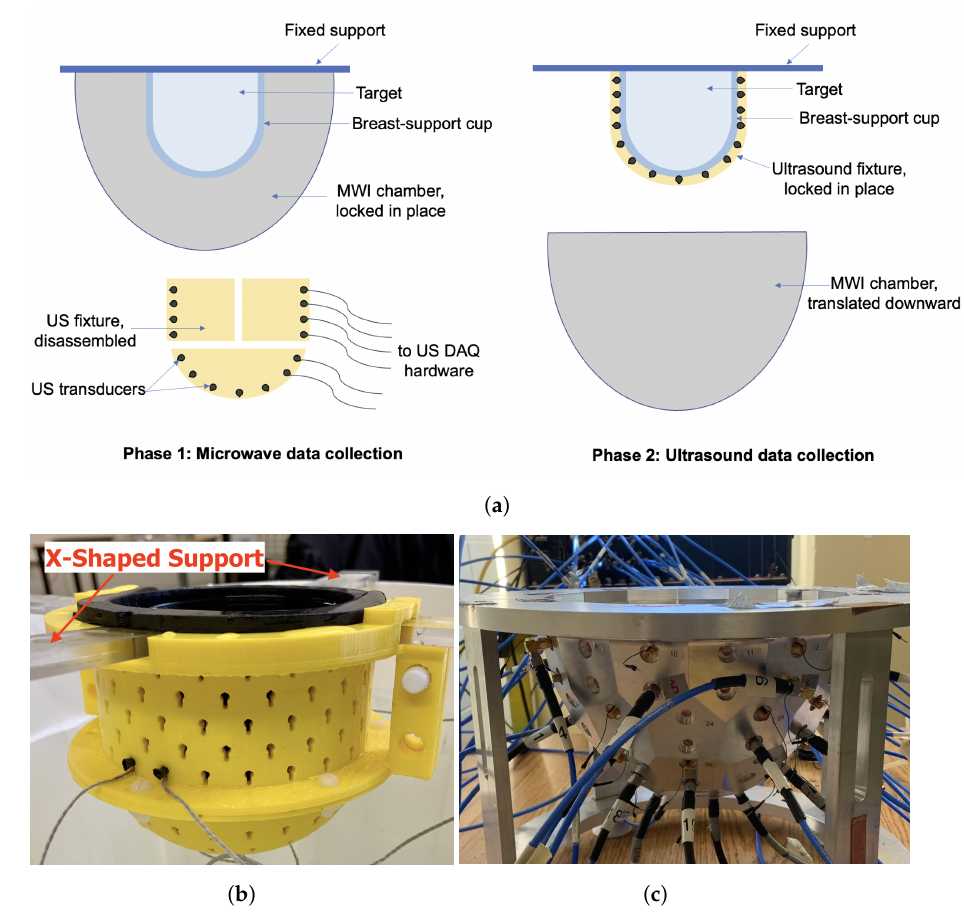
Figure 1. Dual-mode data collection. ( a ) Conceptual diagram. ( b ) US fixture positioned with breast phantom and X-shaped support. ( c ) MWI